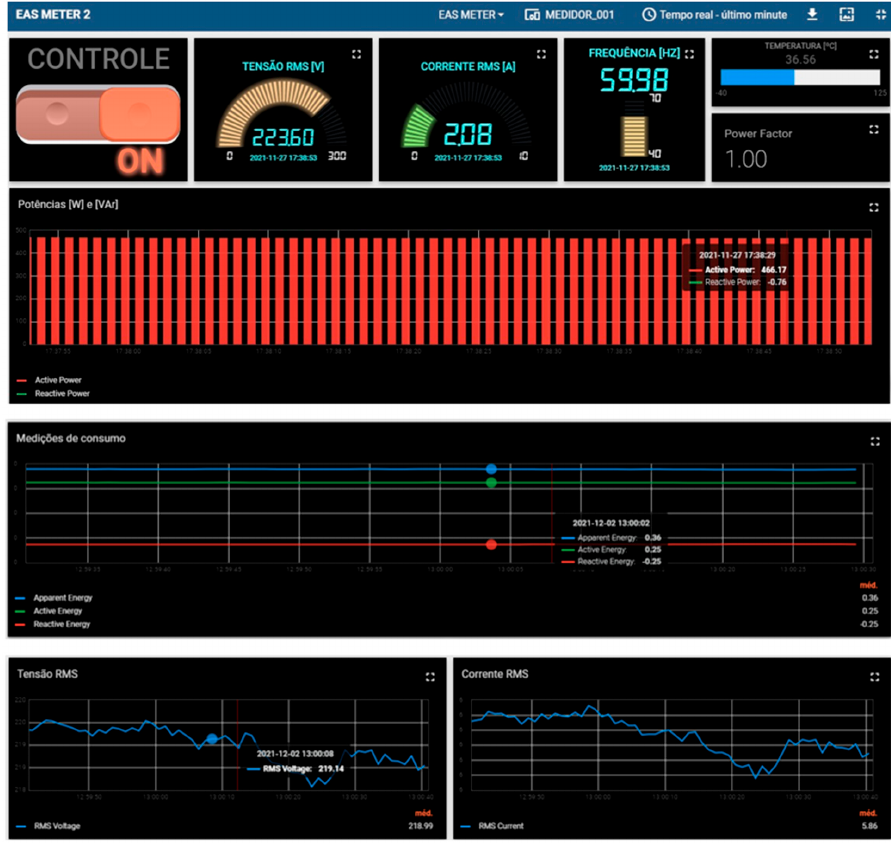
Figure 5. Dashboard of the EAS METER.